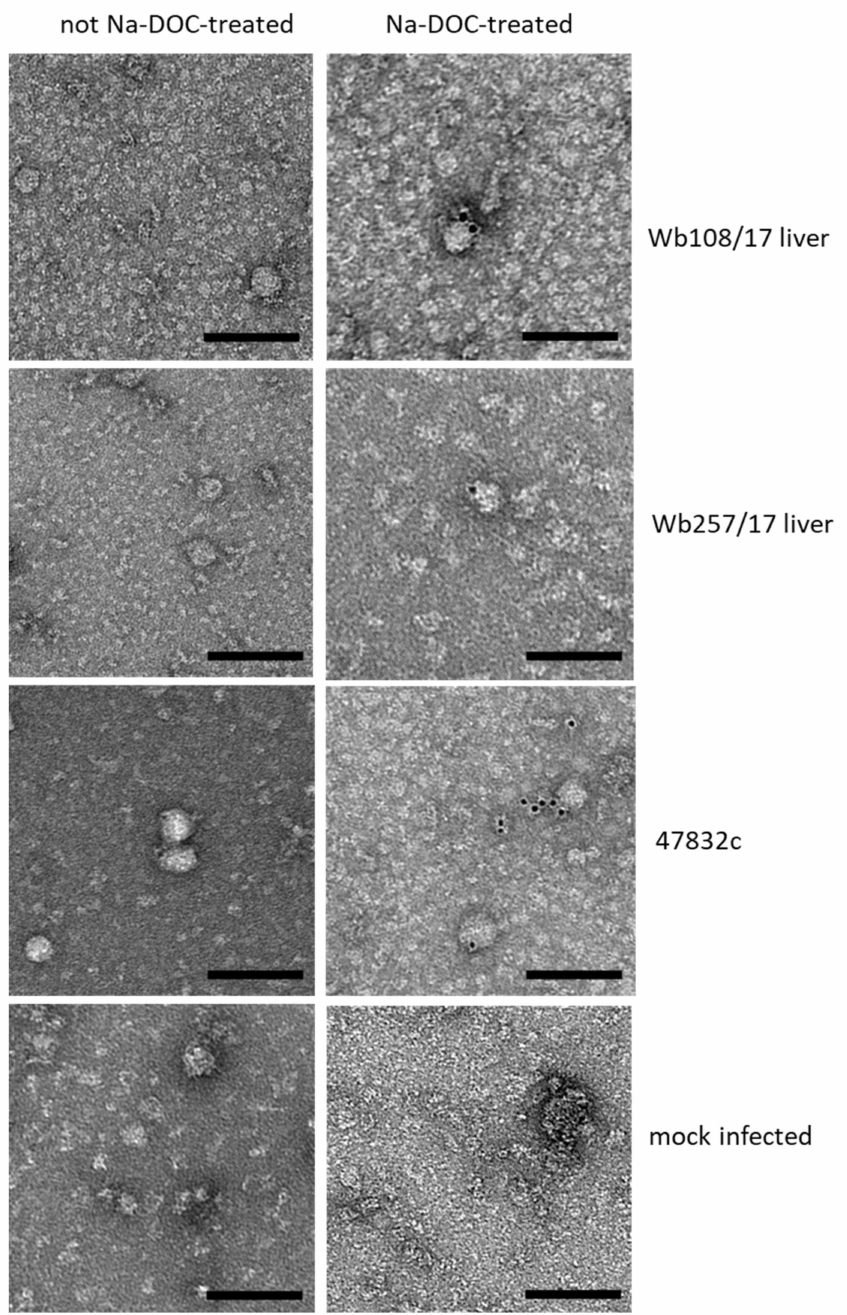
Figure 4. Analysis of particle morphology by immunogold staining and transmission electron microscopy. Samples, as indicated on the right side of the images per row, were treated (right image) with sodium deoxycholate (Na-DOC) to remove the quasi-envelop from HEV, or not treated (left image). Immunogold-staining was done using an anti-HEV capsid protein-specific monoclonal antibody together with a gold-labeled secondary antibody. Black dots represent the gold particles. Negative staining with uranyl acetate. Scale bar: 100